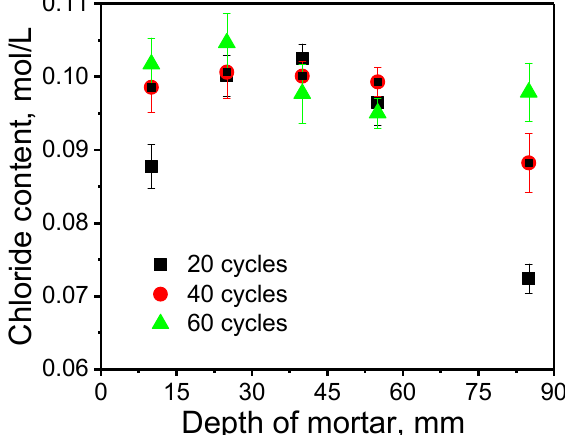
Figure 9. The chloride distribution at 20, 40, 60 cycles.